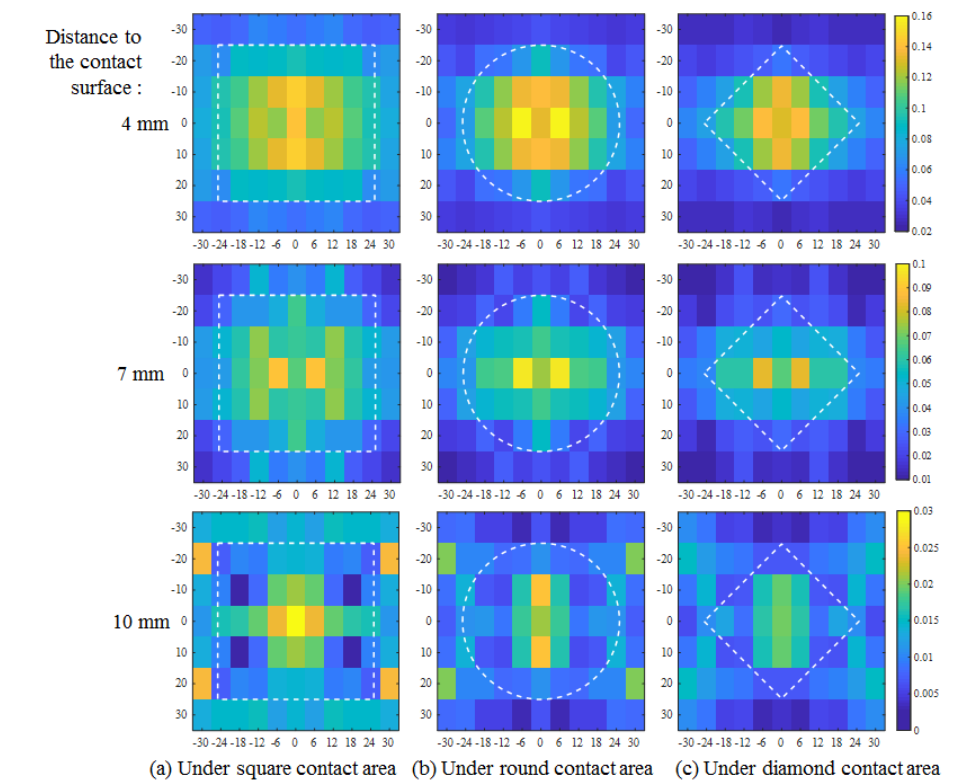
Figure 12. Distributions of shear strain amplitude detected from 24 units of PVDF films extended by central symmetry under three contact shapes plotted on the responding range